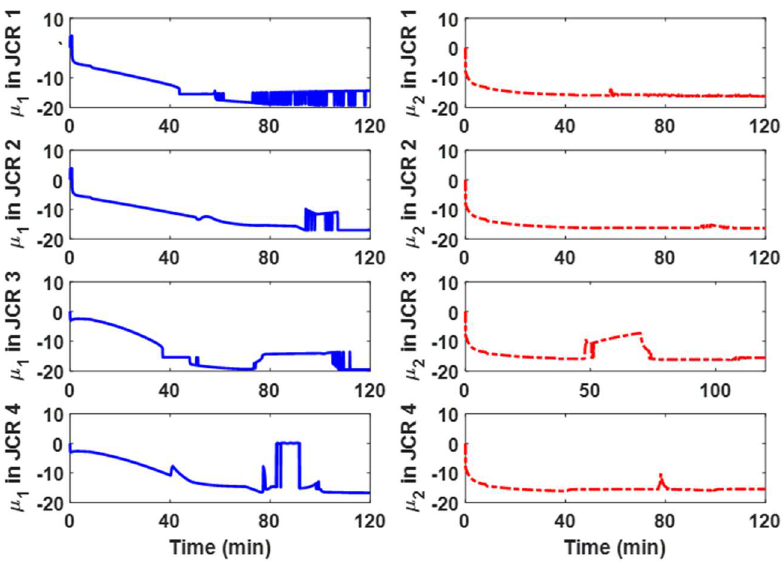
Figure 9. Correction gains µ 1 and µ 2 for different operating modes, where solid lines (blue) are the correction gain used for core temperatures and the dash-dotted line (red) are the results of surface temperature.